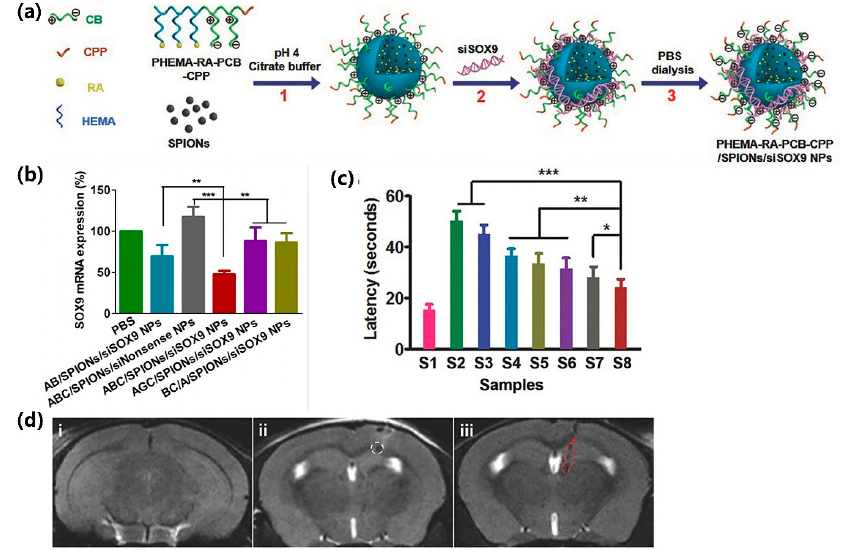
Figure 5. ( a ) Preparation of siRNA-RA NPs. ( b ) Knockdown the expression level of SOX-9 mRNA. ( c ) The latency in target quadrant in Morris water maze (MWM). ( d ) Representative in vivo T 2 MRI images of brains with PHEMA-RA-PCB-CPP/SPIONs/siSOX-9 NPs. (S1) wild, (S2) PBS, (S3) NSCs alone, (S4) PHEMA-RA-PCB-CPP/SPIONs/si-nonsense NPs NSCs, (S5) PHEMA-PCB-CPP/RA/SPIONs/siSOX-9 NPs NSCs, (S6) PHEMA-RA-PEG-CPP/SPIONs/siSOX-9 NPs NSCs, (S7) PHEMA-RA-PCB/SPIONs/siSOX-9 NPs NSCs, and (S8) PHEMA-RA-PCB-CPP/SPIONs/siSOX-9 NPs